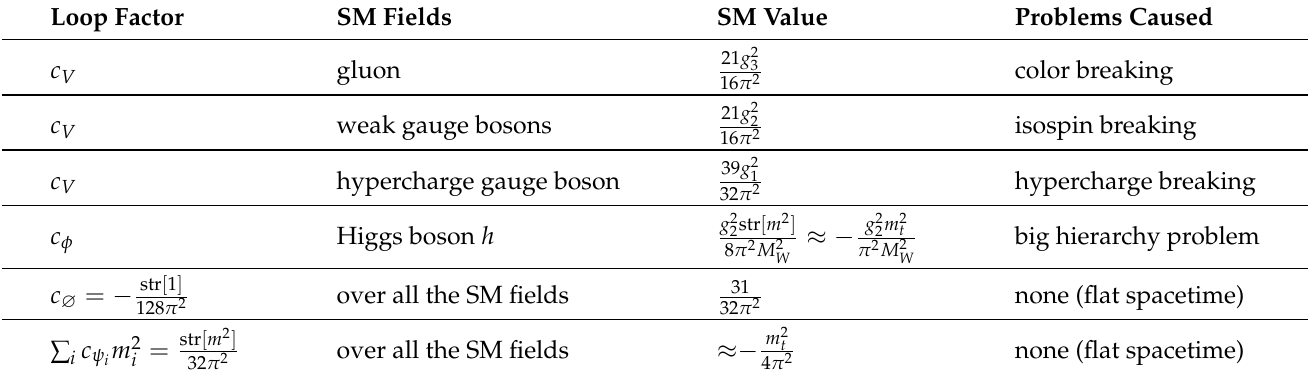
Table 1. The loop factors c V at one loop and various problems they cause (taken from Reference